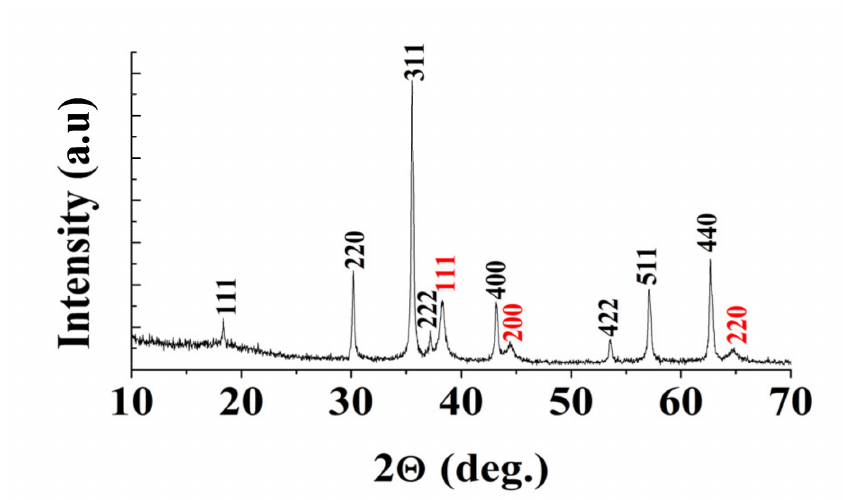
Figure 5. XRD pattern of CoFe 2 O 4 /Au nanoparticles after 10 gold deposition cycles from the alkaline (pH = 12) solution containing 0.03 mol/L HAuCl 4 and 0.03 mol/L methionine at 37 ◦ C for 4 h: the reflexes corresponding to CoFe 2 O 4 are marked in black, and the reflexes corresponding to Au are marked in red.